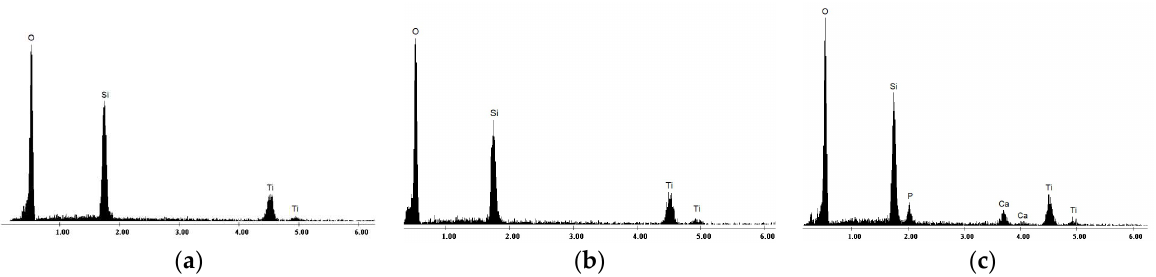
Figure 3. ( a ) Average surface roughness ( Ra ) of Ti substrate, Ti PEO DC; Ti PEO PC; Ti PEO PC +